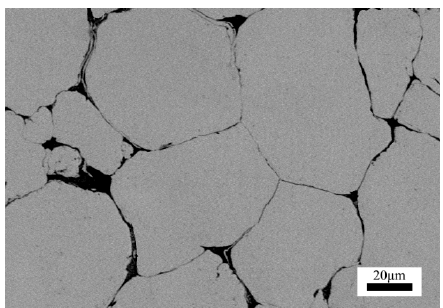
Figure 6. Cross section SEM image of Fe 3 O 4 –MnZnFe 2 O 4 coated iron-based composite.